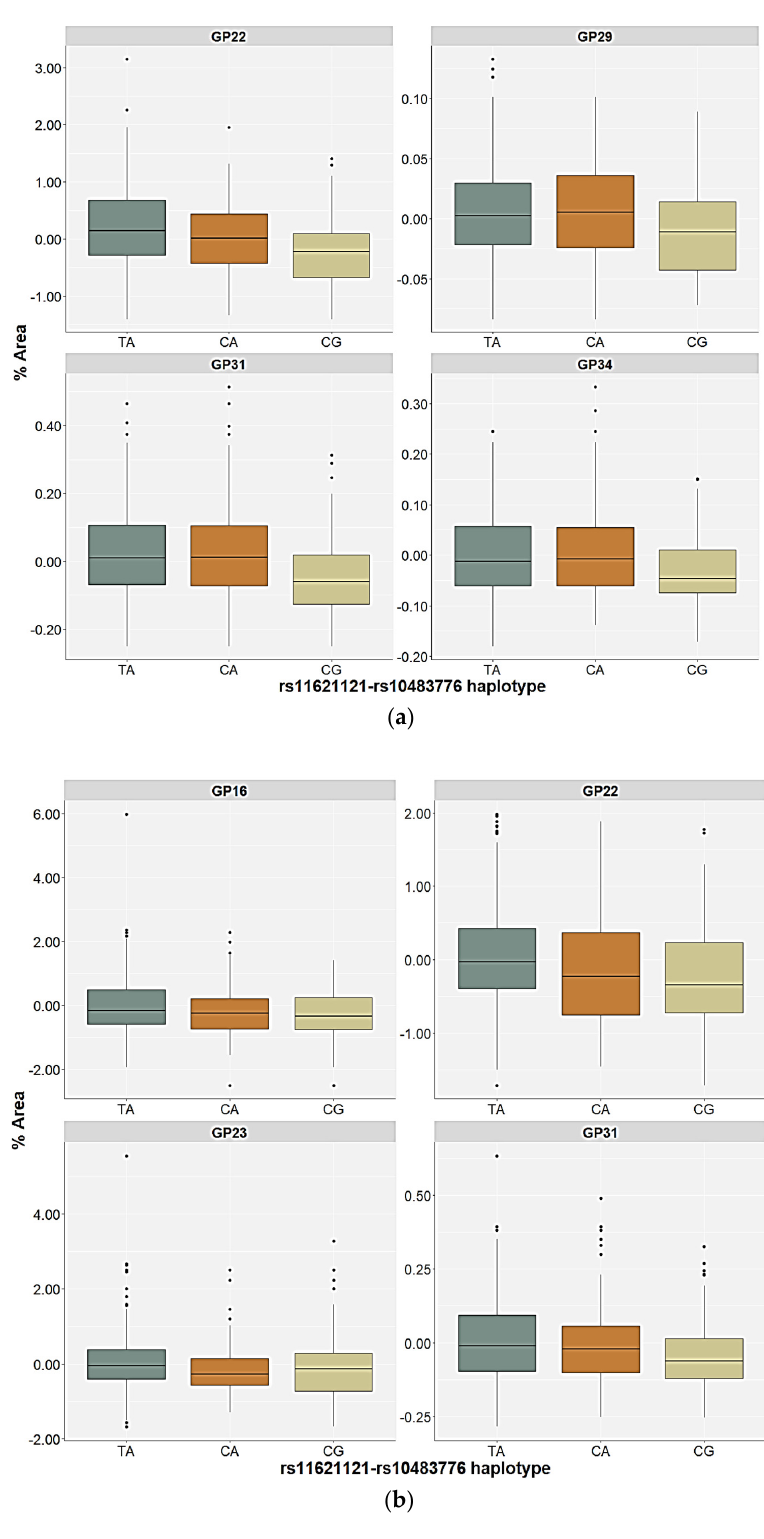
Figure 5. Relative distribution of the plasma N-glycan levels in the carriers of the different rs11621121–rs10483776 haplotypes in the ( a ) control and ( b ) PTSD group. The central box represents the interquartile range of the age-adjusted percentage of the total glycan peak area, the middle line represents the median, the vertical line extends from the minimum to the maximum value, and separate dots represent the outliers.